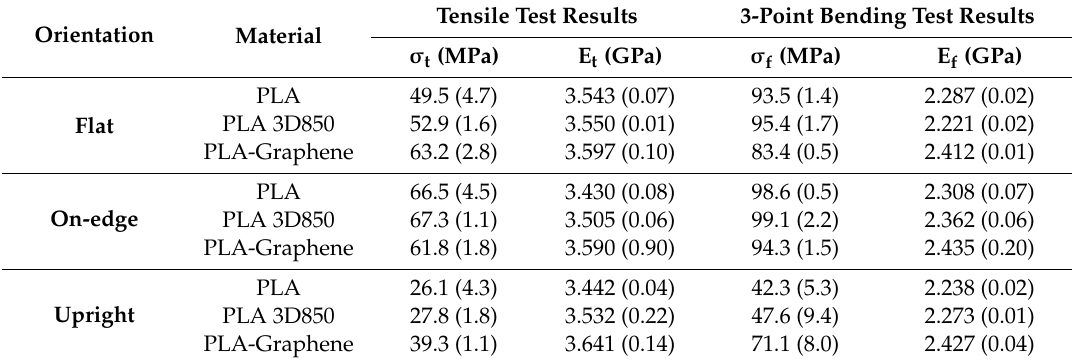
Table3. Averagetensileandflexuralstrengthandsti ff nessresultsofPLA,PLA3D850andPLA-Graphene samples for Flat, On-edge and Upright orientation. Standard deviation is depicted in brackets.